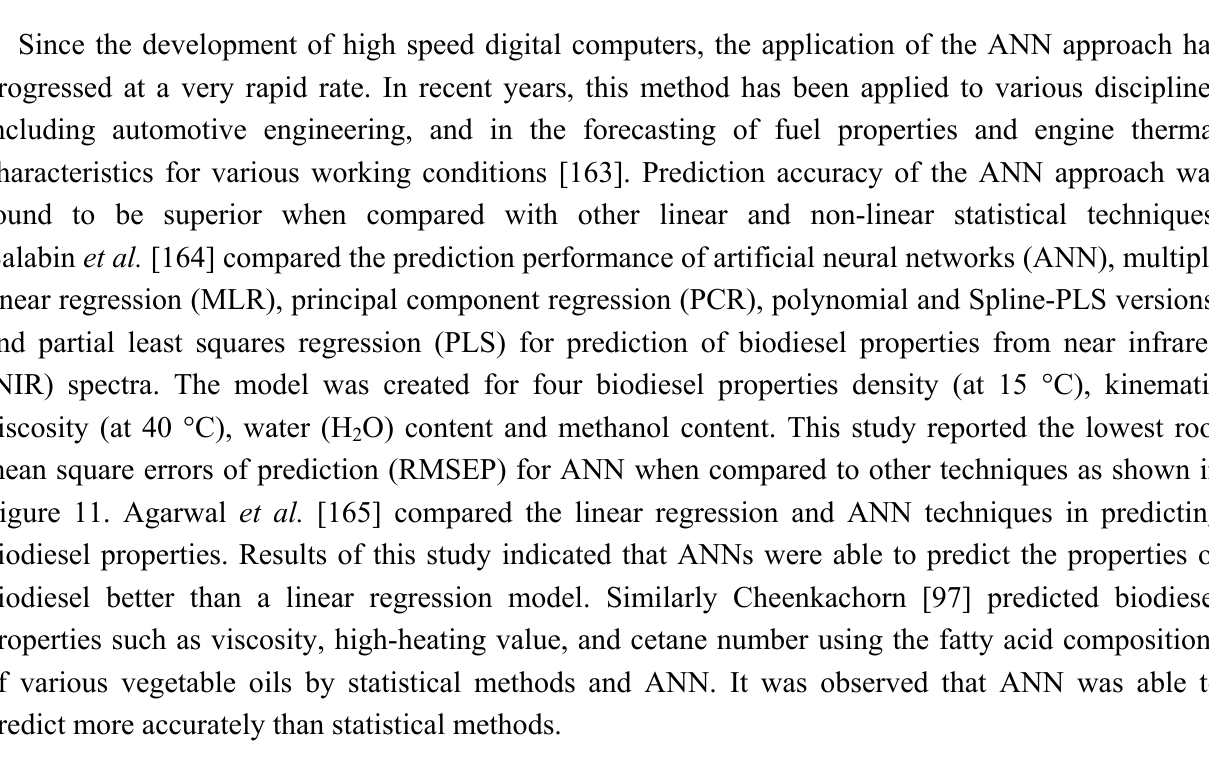
Figure 11. Comparison of the performance of between ANN and various linear and non-linear prediction techniques